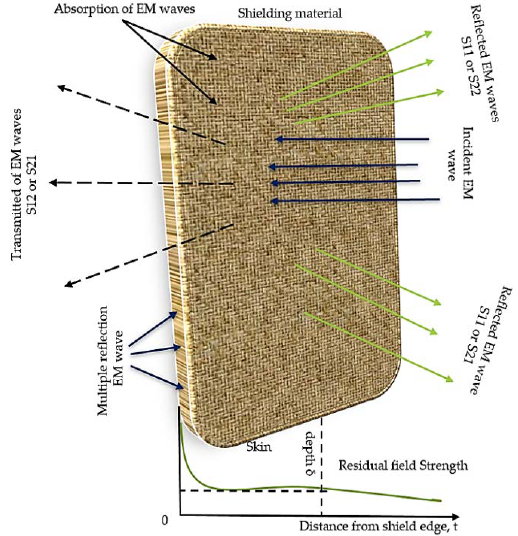
Figure 5. Graphical representation of incident electromagnetic (EM) wave interaction with shield